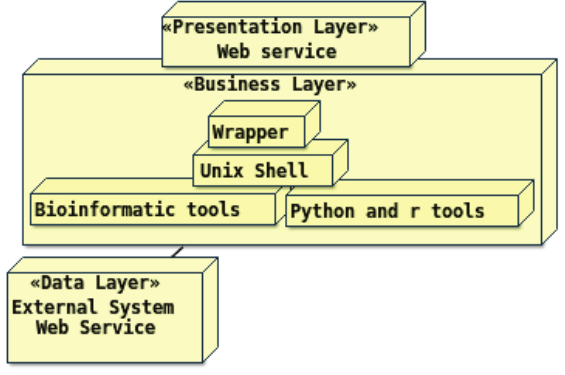
Figure 4: GITIRBio Low Level Architecture.